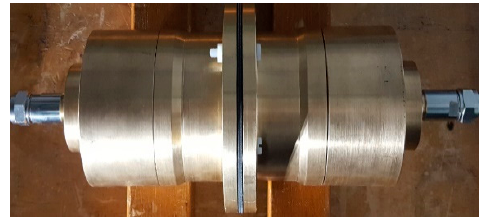
Figure 4. The specimen apparatus used for the EMSE tests.